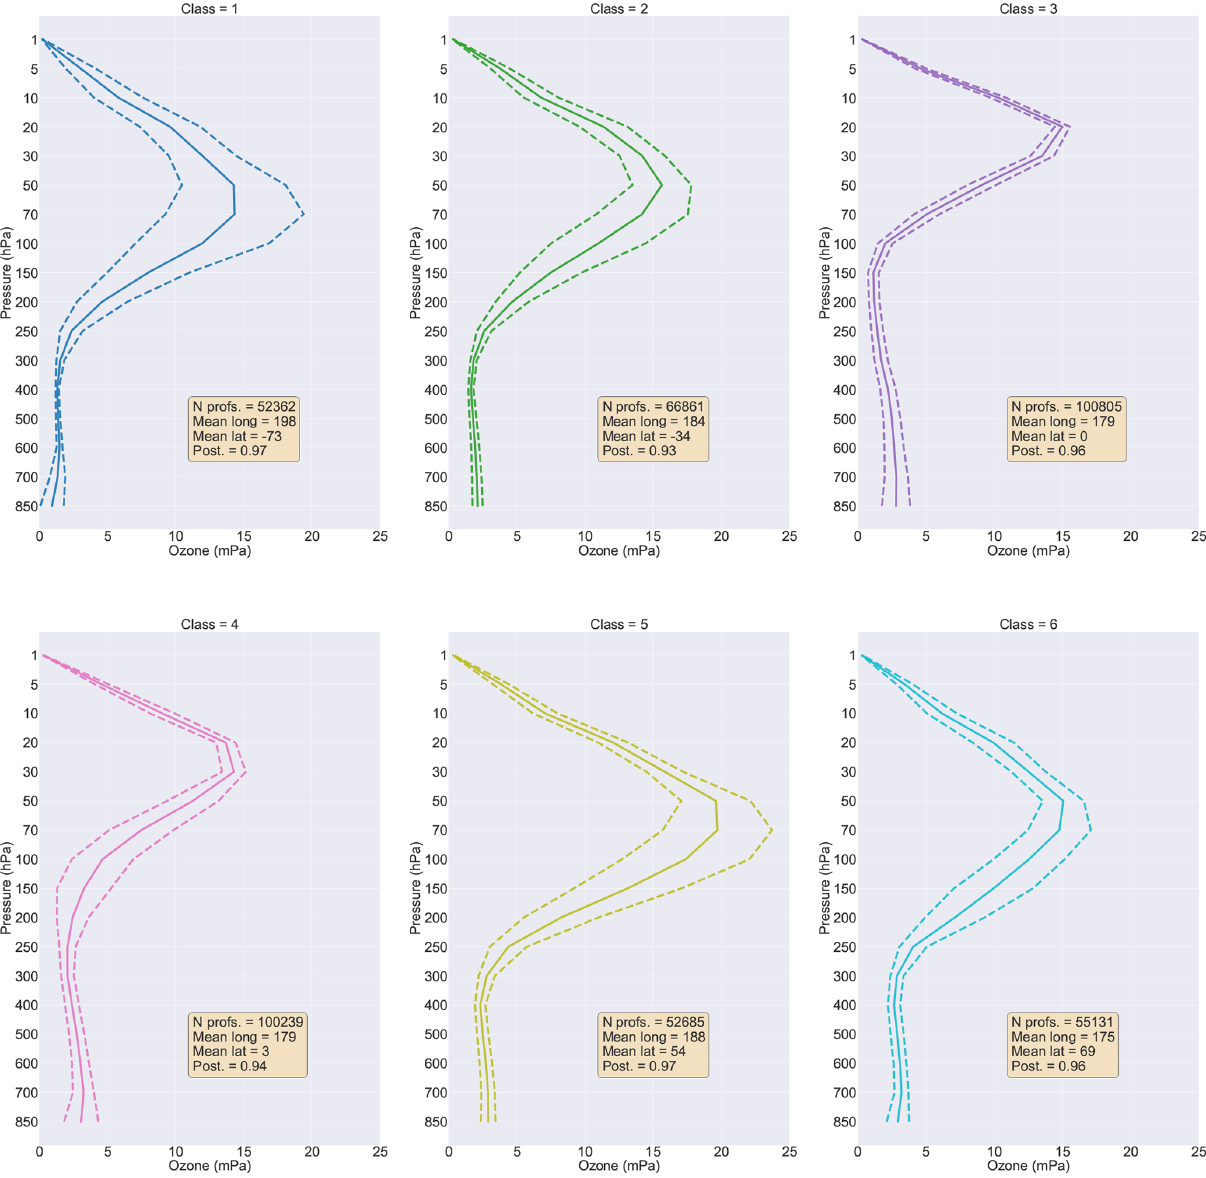
Figure 2. Ozone concentration statistics of UK Earth System model data for the whole dataset, separated by class, as a function of pressure, sorted by latitude. Shown are the mean (solid lines) and the mean plus or minus 1 standard deviation (dashed line) for all profiles in the indicated class. Also shown are the number of profiles in each class and the class mean values for longitude, latitude, and posterior